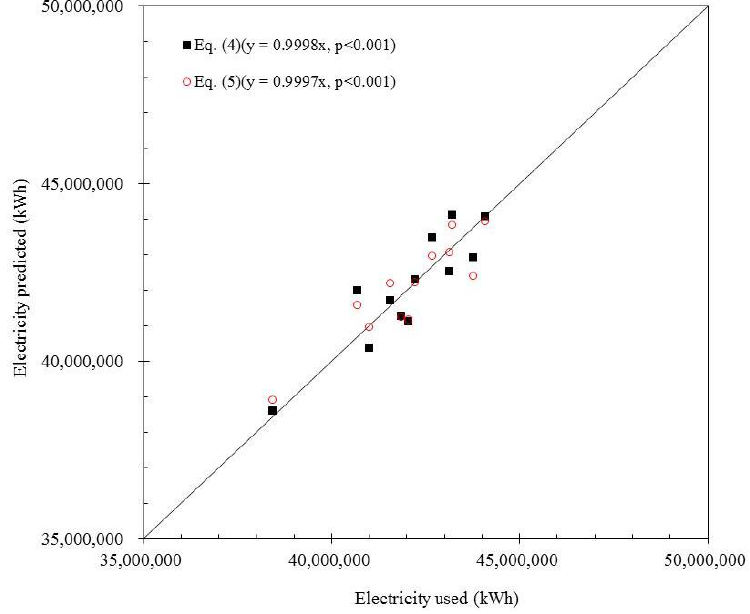
Figure 4. Comparisons of measured and predicted values of electricity consumption in 2010.